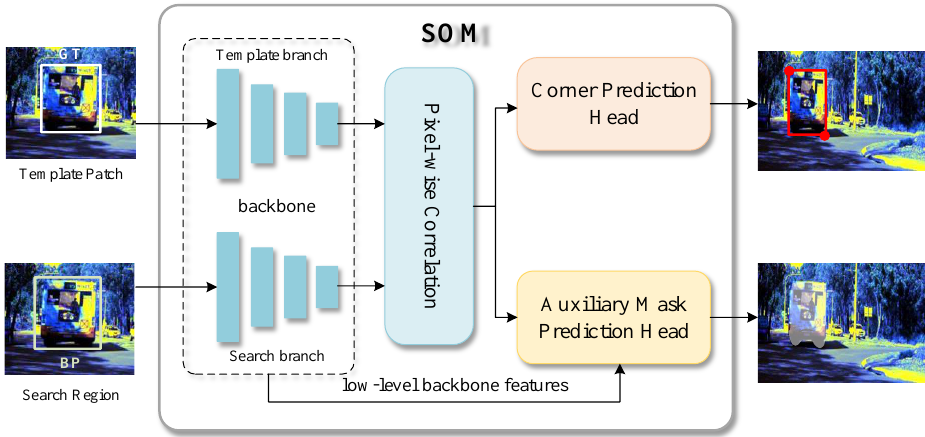
Figure 8. The structure of the SOM. Among them, ‘GT’ represents the groundtruth of the object, and ‘BP’ represents the object’s bounding box predicted by the subject